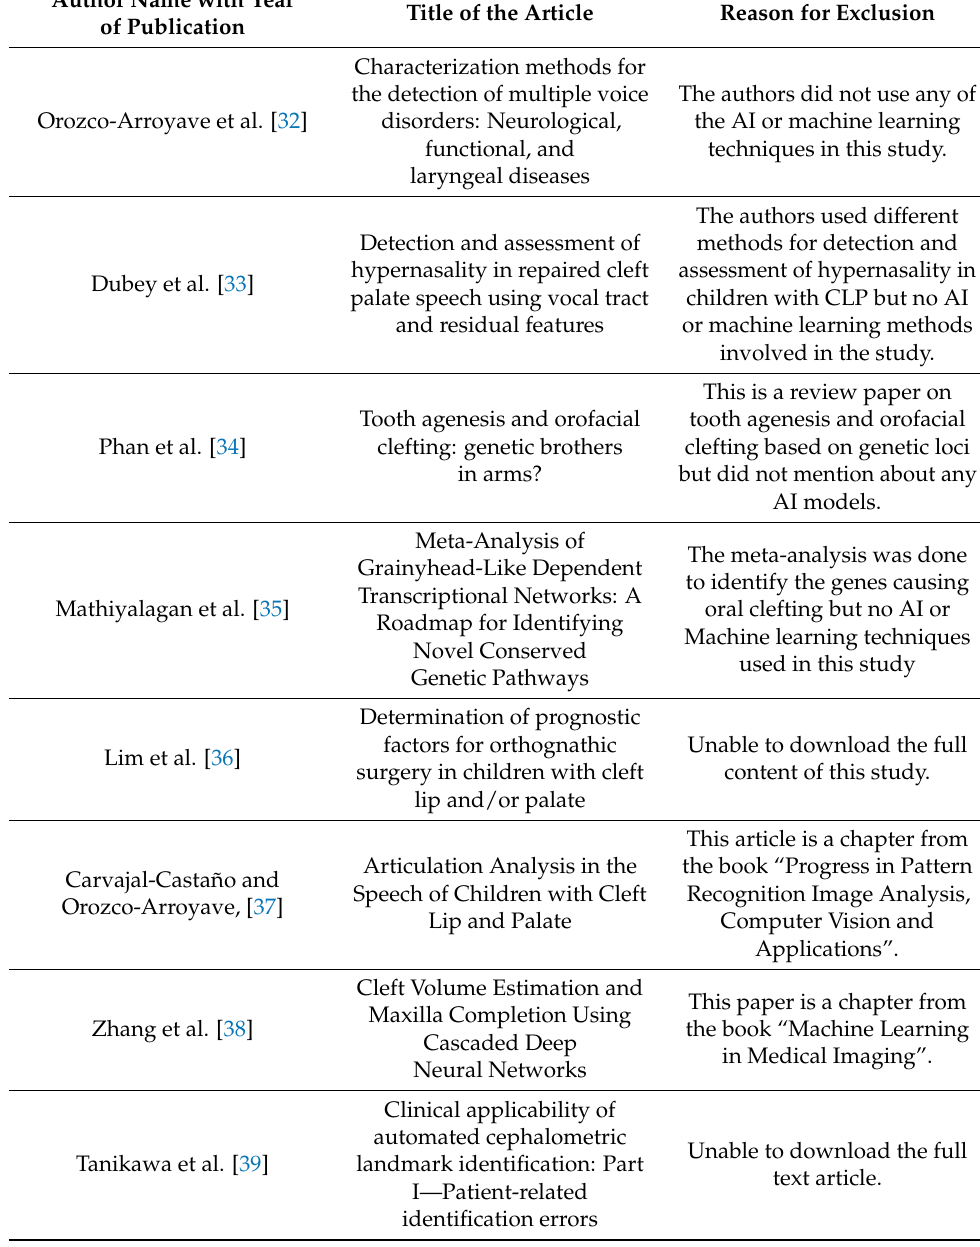
Table 3. Articles excluded and reason for exclusion after reading the full